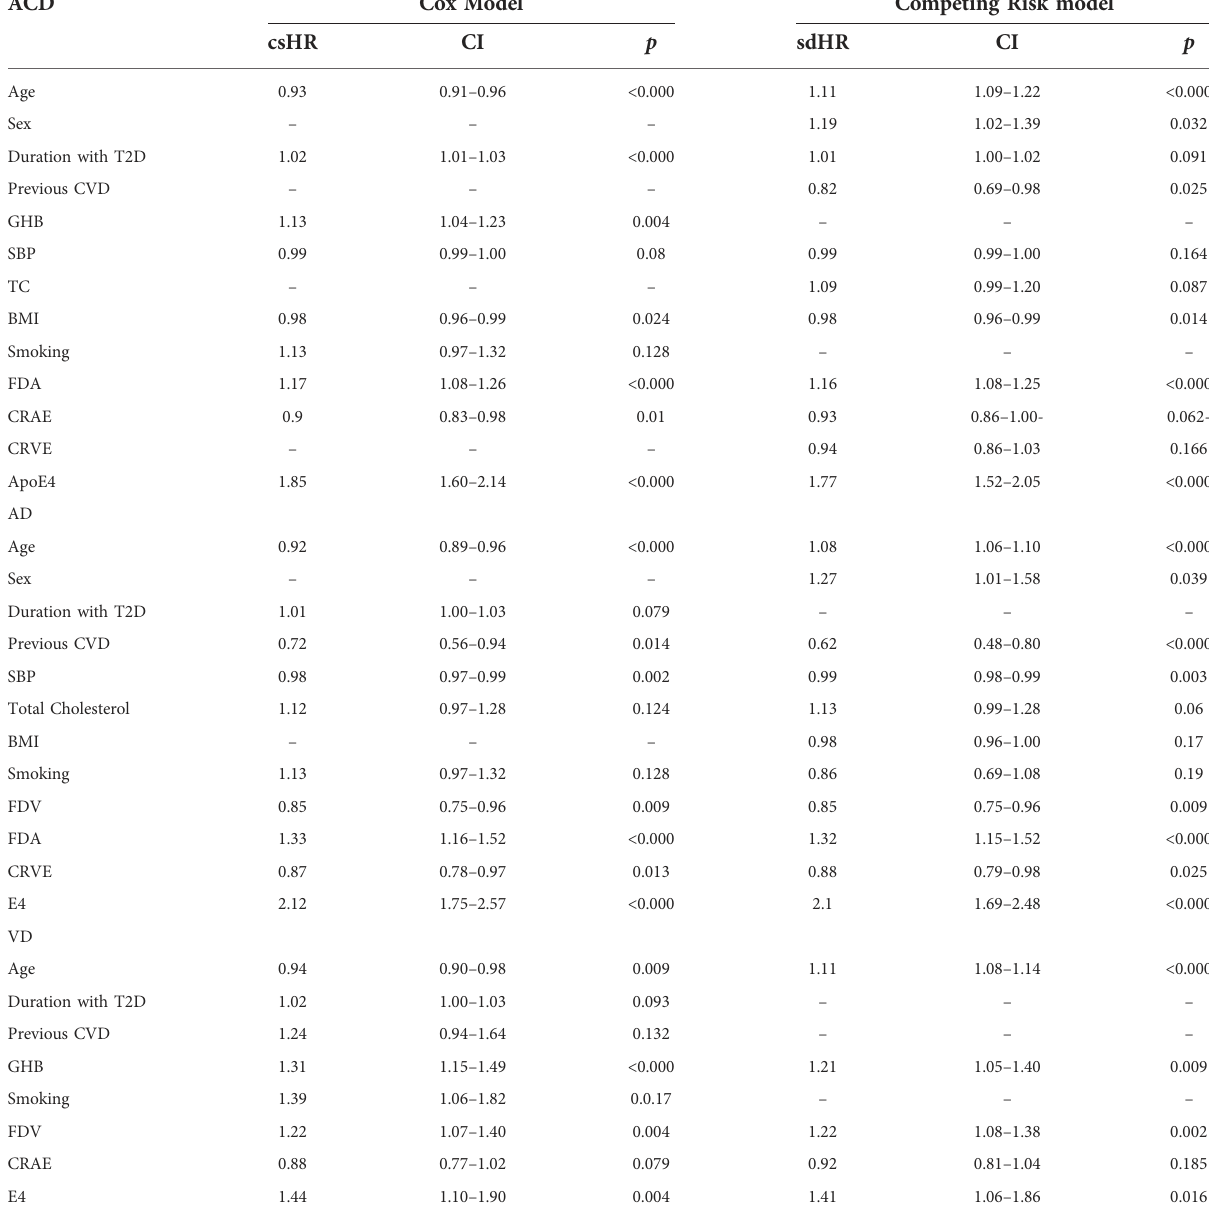
TABLE 2 Covariates remaining in the Cox and competing risk models after stepwise removal for ACD, AD and VD (- denotes removed